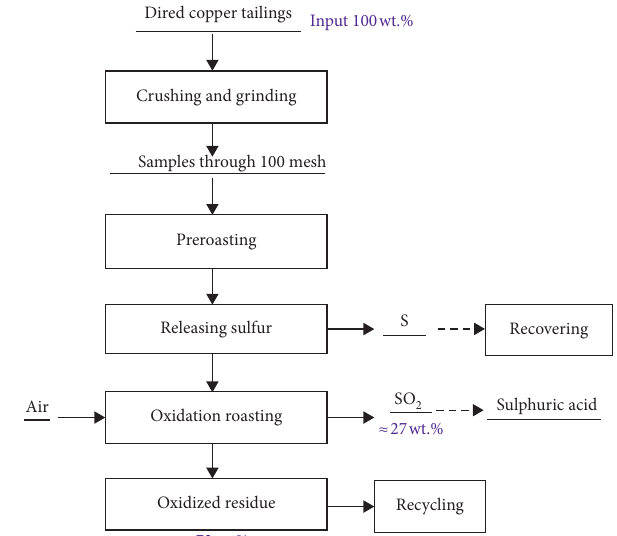
Figure 1: Experiment equipment for oxidation roasting: (1) absorption liquid, (2) monitor of SO (5) alumina crucible, (6) tube furnace, (7) pressure gage, (8) flow meter, (9) air blower, (10) nitrogen cylinder, and (11) condenser pipe.